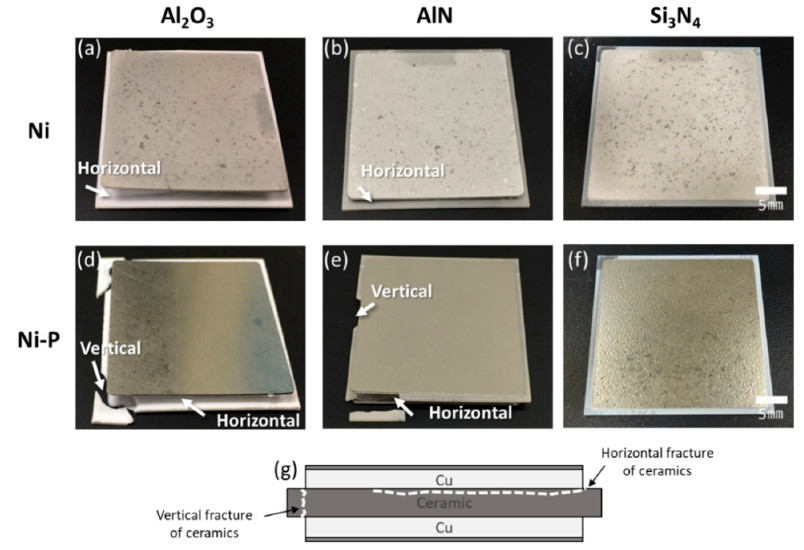
Figure 3. Destructed AMB substrates with Al 2 O 3 ( a , d ) and AlN ( b , e ) after 10 cycles, nondestructed AMB substrates with Si 3 N 4 ( c , f ) after 1000 cycles plated with Ni ( a – c ) and Ni–P ( d – f ), and ( g ) fracture pattern of AMB substrates.